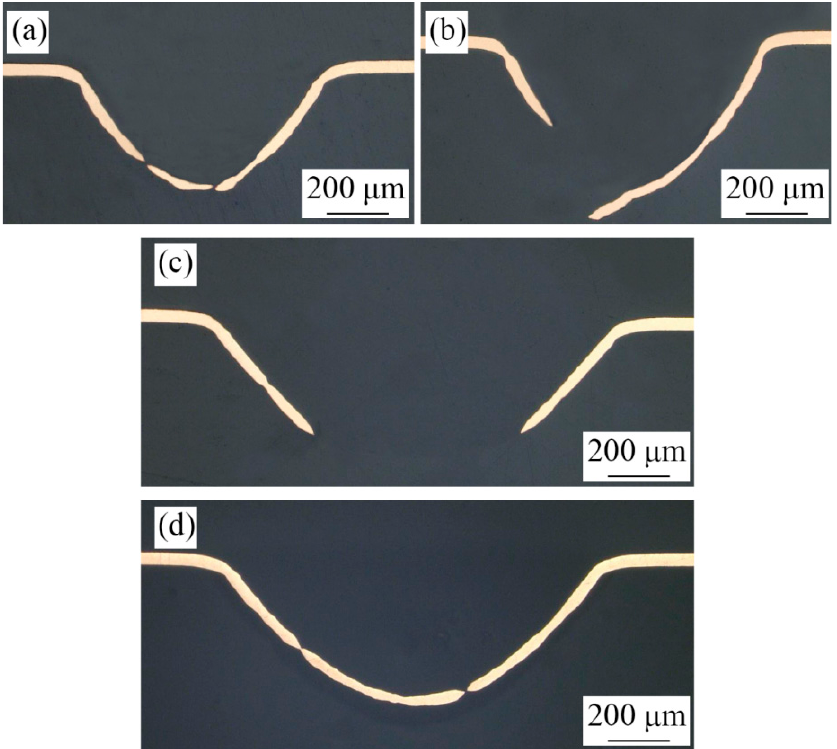
Figure 11. Effect of LPS on the section morphologies of bulging samples annealed at 650 °C. ( a ) λ = 0.25, 725 mJ, without LPS; ( b ) λ = 0.25, 725 mJ, with LPS; ( c ) λ = 0.5, 575 mJ, without LPS; ( d ) λ = 0.5, 575 mJ, with LPS.